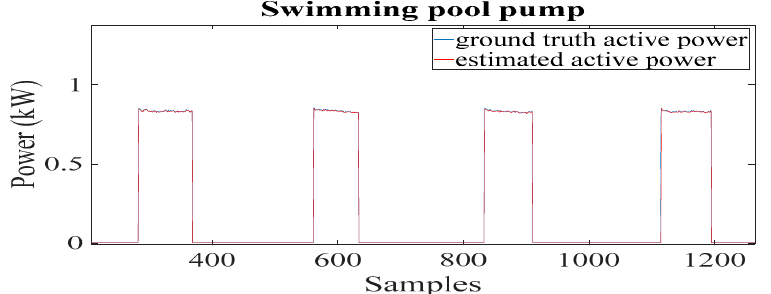
Figure 7. Swimming pool pump: blue, ground truth active power; red, estimated active power.